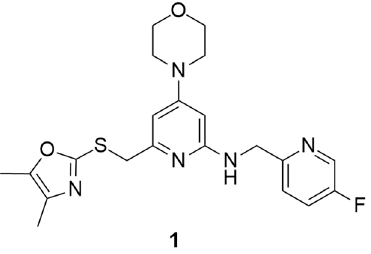
Figure 1. Structure of Y 1 receptor antagonist 1 .